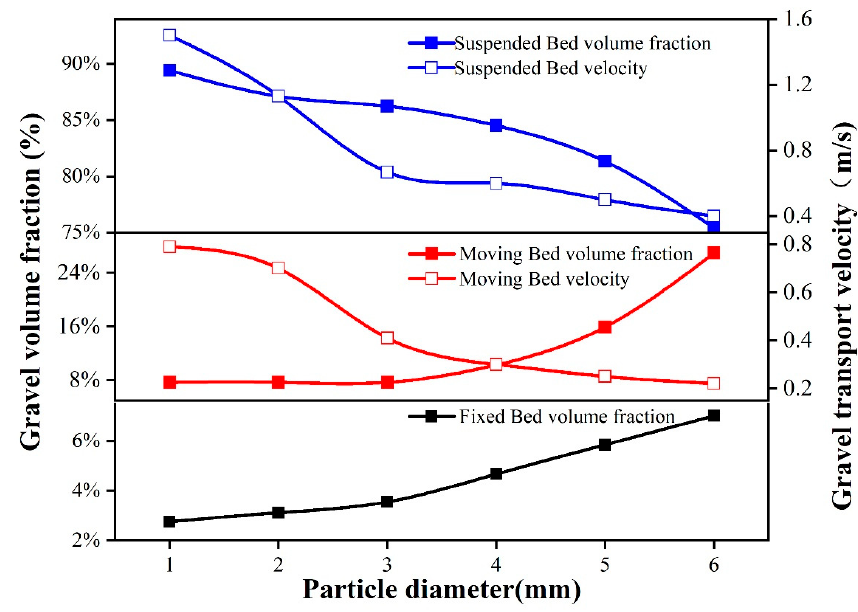
Figure 14. Graph of the effect of particle size on volume fraction and migration velocity.